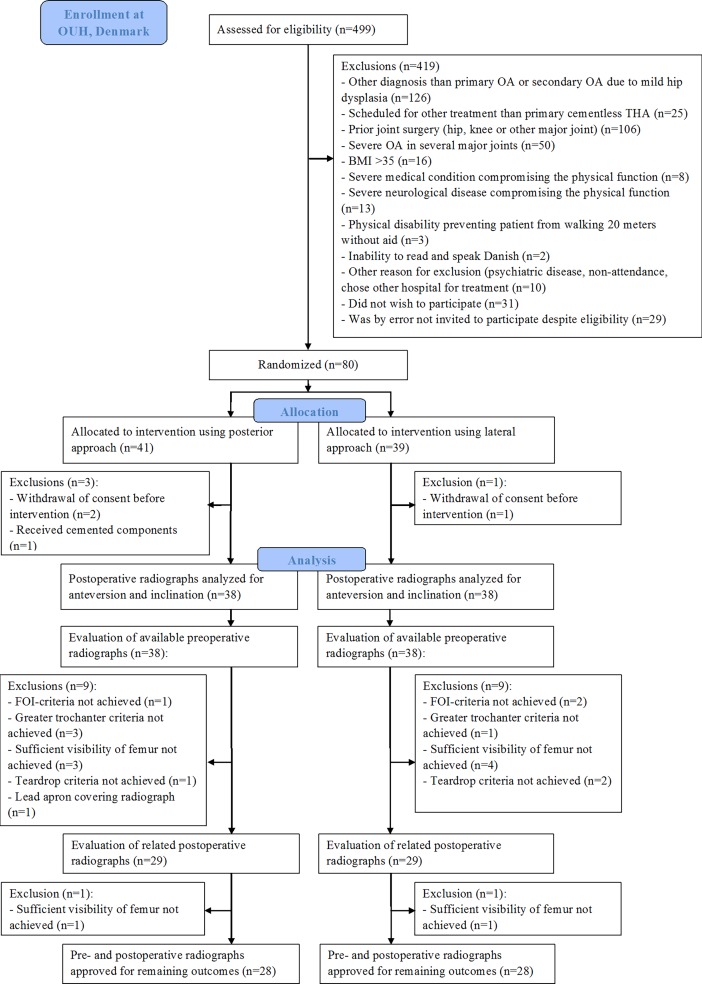
CONSORT flow diagram for enrolment of the patients according to inclusion and exclusion criteria and available radiographs.Please see text in ‘Participants’ and ‘Data collection’ for the trial’s inclusion criteria and the study’s radiographic inclusion criteria.